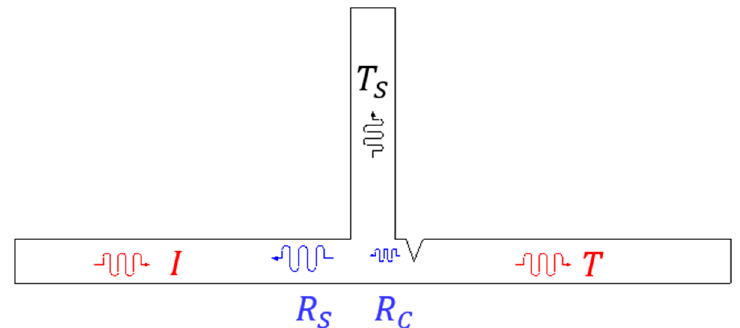
Figure 2. Schematic of Lamb wave propagation along a stiffened plate with a crack: I , R S and R C represent the incident wave, stiffener reflected wave and crack reflected wave, respectively. T S and T are the leaked wave to the stiffener and transmitted wave through the stiffener and crack, respectively.